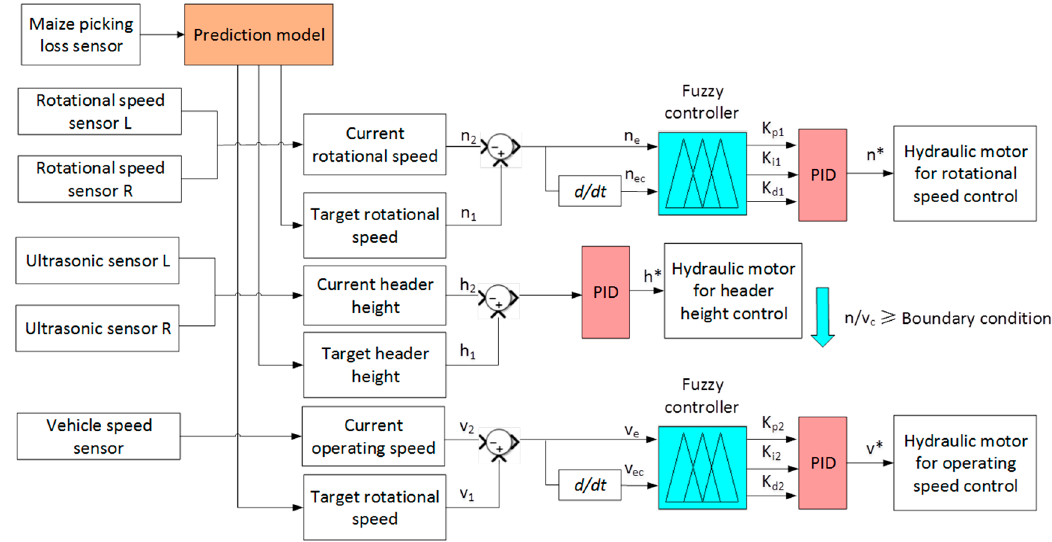
Figure 4. Control block diagram of intelligent control system for maize picking. n*, h*, v* are the outputs value of three controllers.